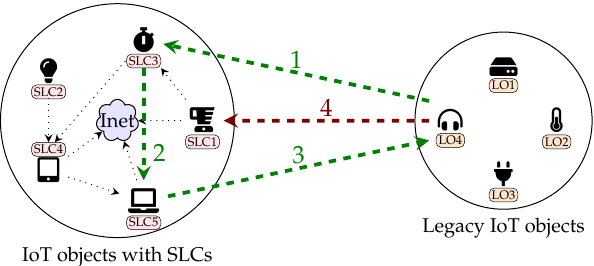
Figure 2. Integration the legacy objects with our